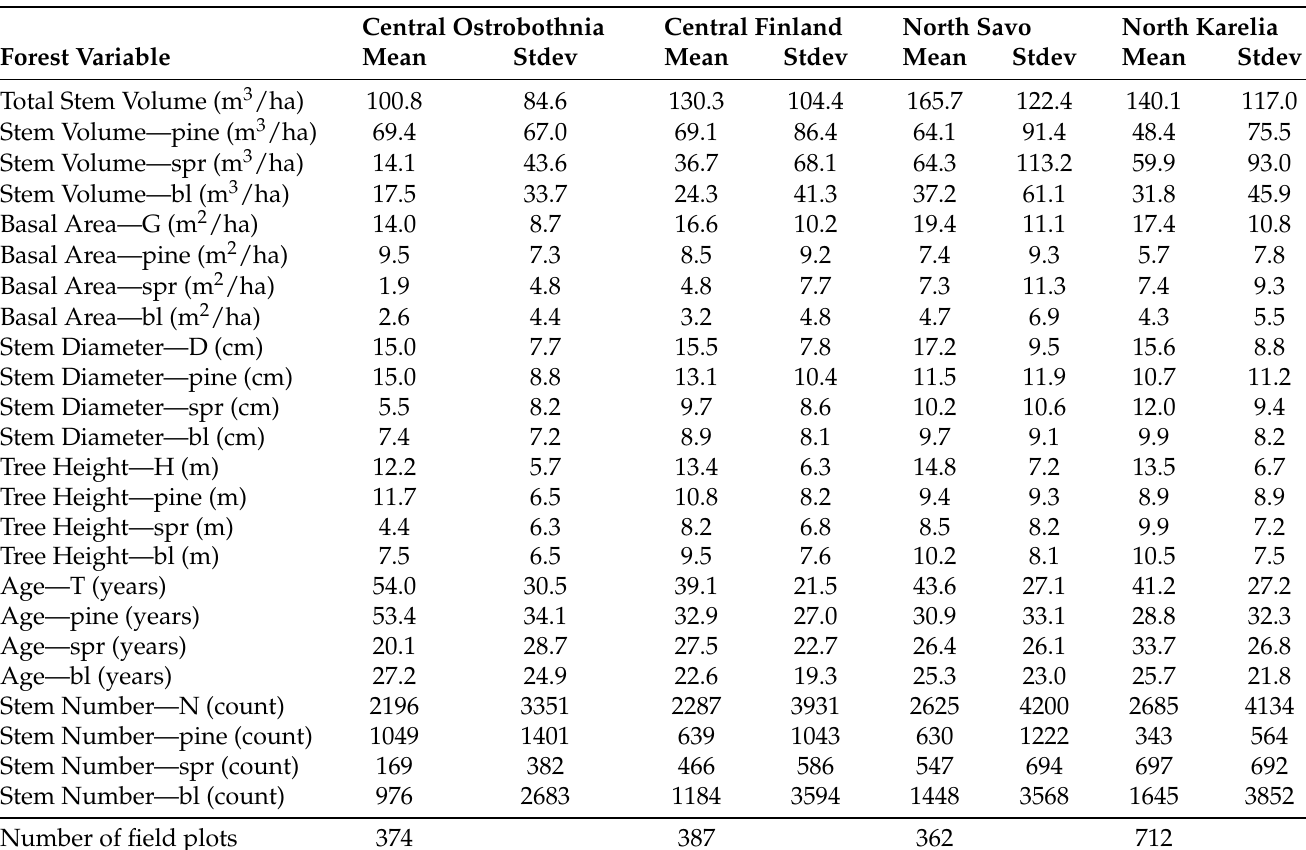
Table 1. Forest variable means and standard deviations (Stdev) for the four forestry districts. Species-specific values for spruce and broadleaved are indicated by “spr” and “bl”, respectively. Numbers of used field plots for each forestry district are also